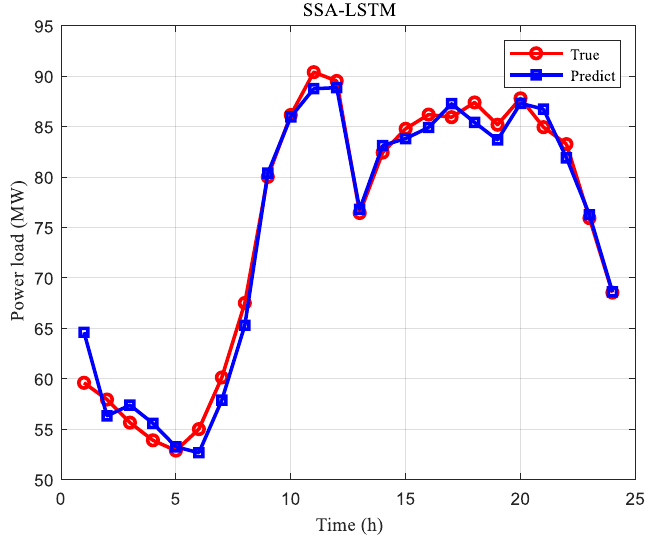
Figure 9. Comparison of SSA-LSTM model prediction curves and real values of power load.